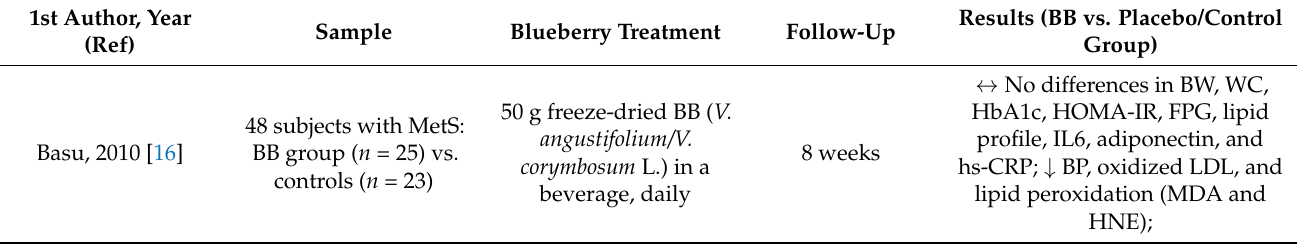
Table 1. Clinical studies that evaluated the effect of blueberry or bilberry consumption on obesity and related-metabolic